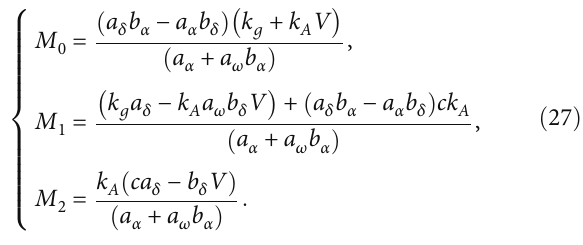
Table 4: Design results of the TD3 algorithm at the feature points. Feature point 1